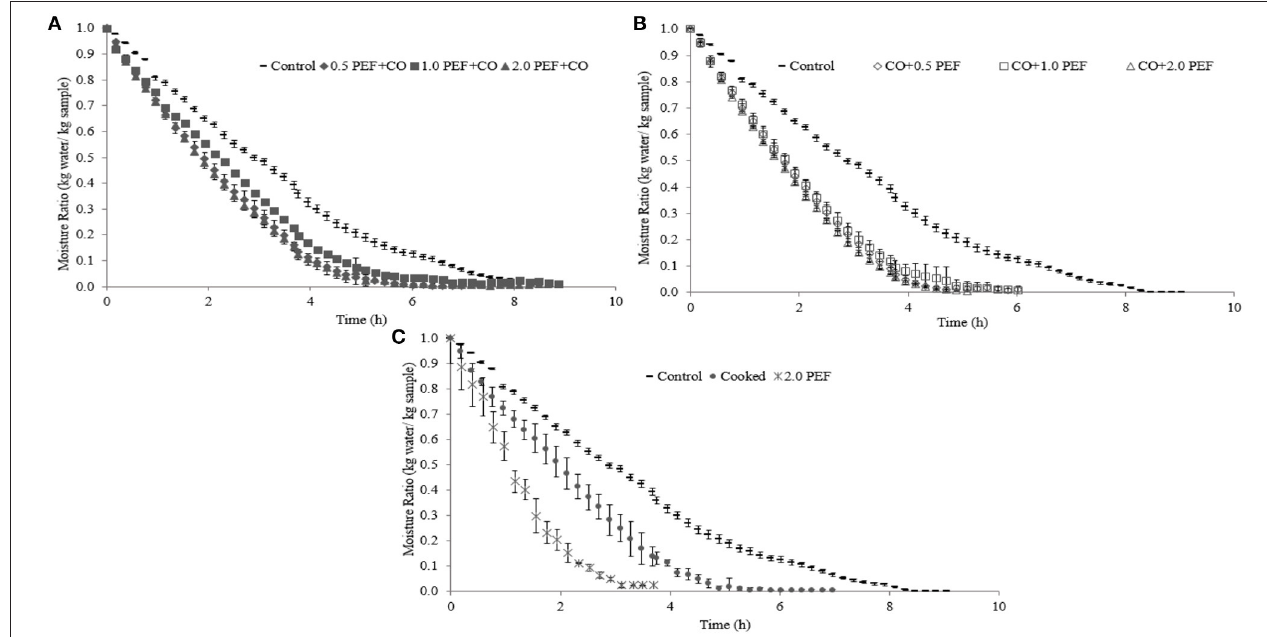
FIGURE 1 | Freeze-drying (FD) kinetics of samples under different pretreatment conditions: (A) Pulsed electric field (PEF) + cooking (CO) pretreated samples compared to control sample, (B) CO + PEF pretreated samples compared to control sample, and (C) 2.0 PE or CO pretreated samples compared to control sample.